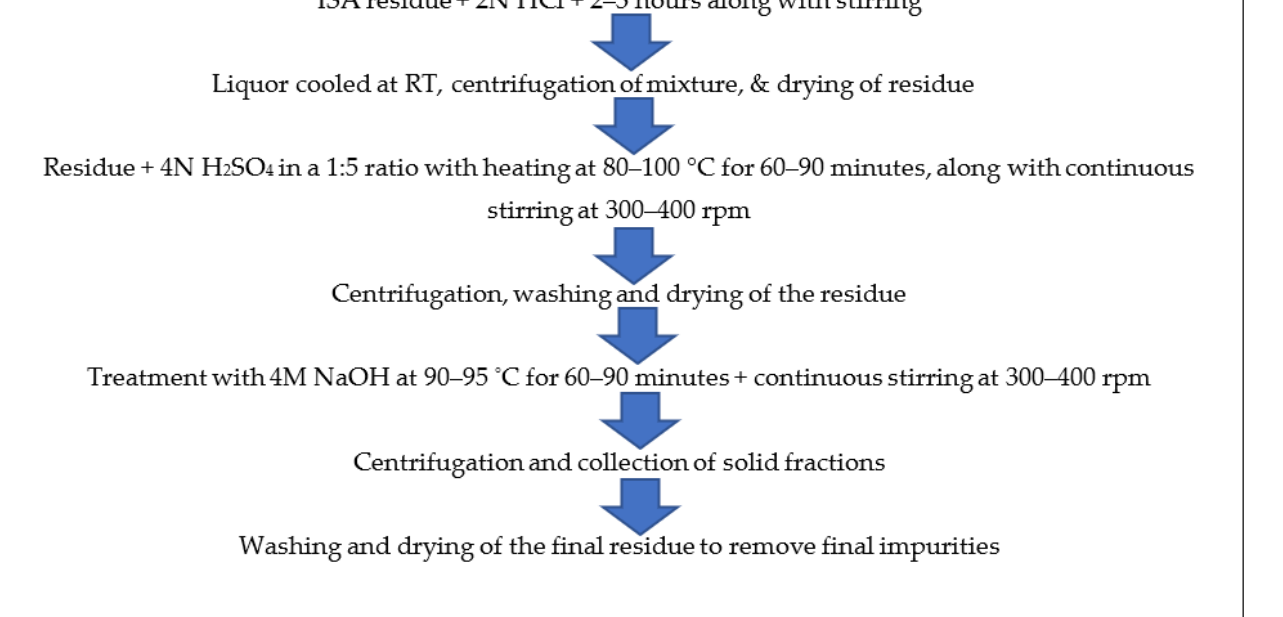
Figure 5. Schematic method for synthesis of calcium oxides from non-magnetic fractions of ISA.